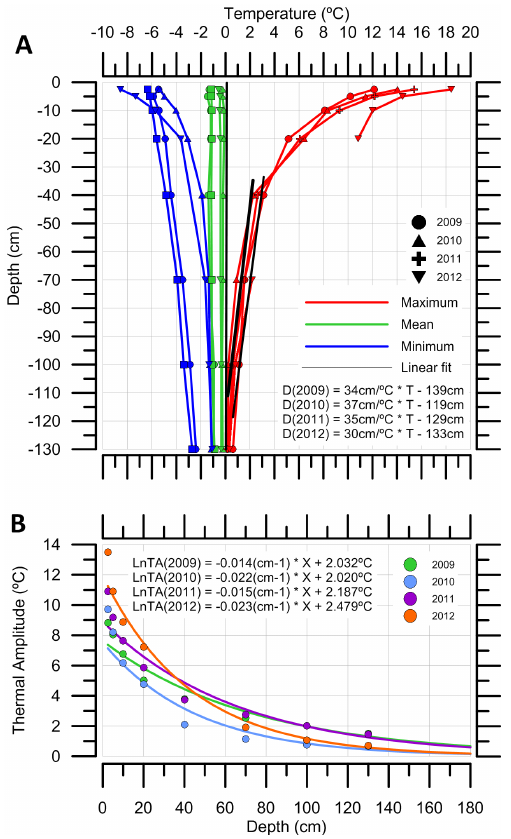
Figure 5. (A) Mean annual air and ground temperatures at different depths used to derive the thermal and surface offset, and (B) their evolution along the study